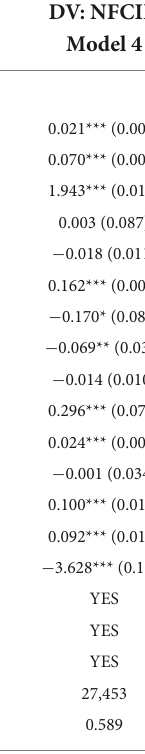
TABLE 5 Estimates for FCID and